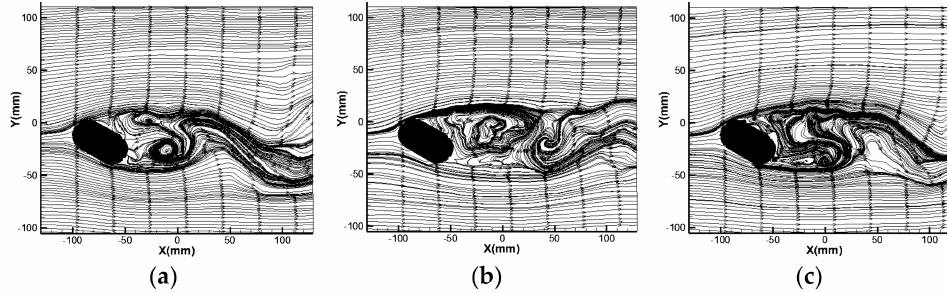
Figure 9. Instantaneous surface flow diagram of flow around a single circular ended pier with α = 30 ◦